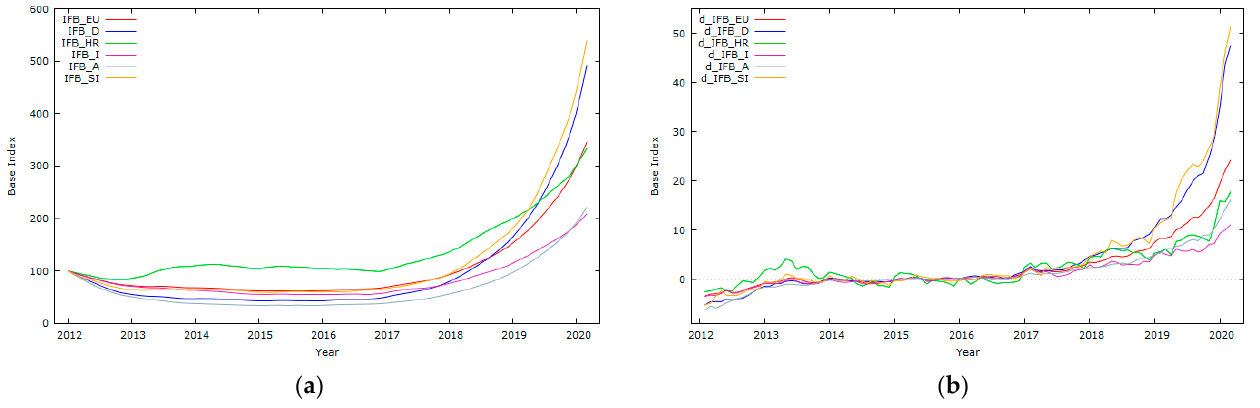
Figure A2. ( a ) Distribution of food and beverages price indices for Austria, Croatia, Germany, Italy, and Slovenia; ( b ) Distribution of 𝐼(1) food and beverages price indices for Austria, Croatia, Germany, Italy, and Slovenia. Note. IFB—Food and beverages price index; EU—Eurozone; D—Germany, HR—Croatia, I—Italy, A—Austria, SI—Slovenia. Data vector January 2012 to March 2020 (expansion period); d— 𝐼(1) .